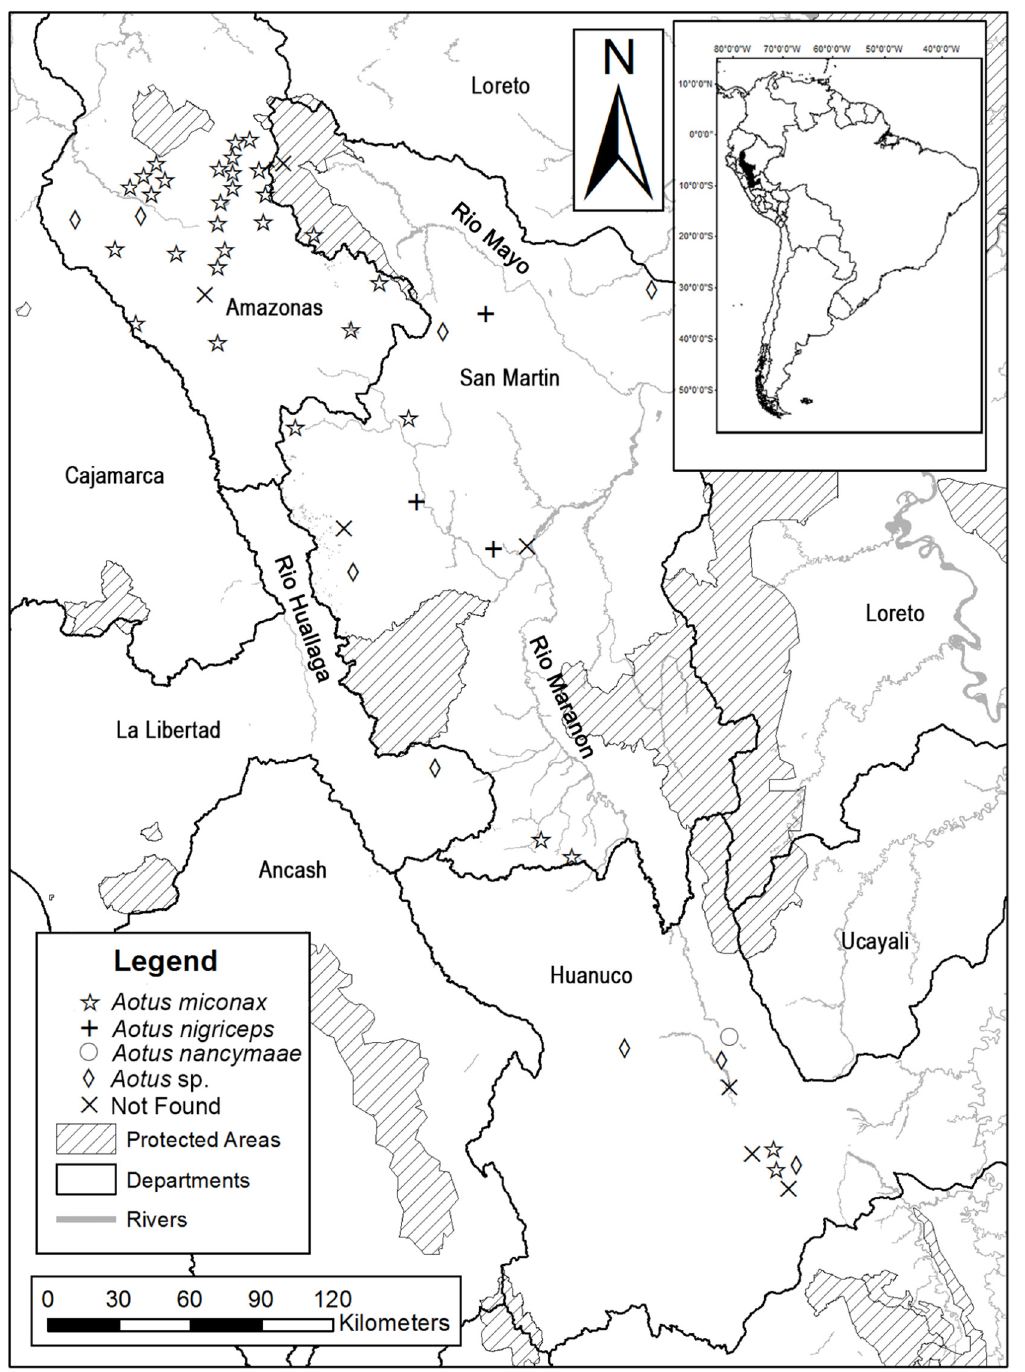
Figure 1. Survey sites showing localities of Aotus miconax , A. nancymaae , A. nigriceps and Aotus